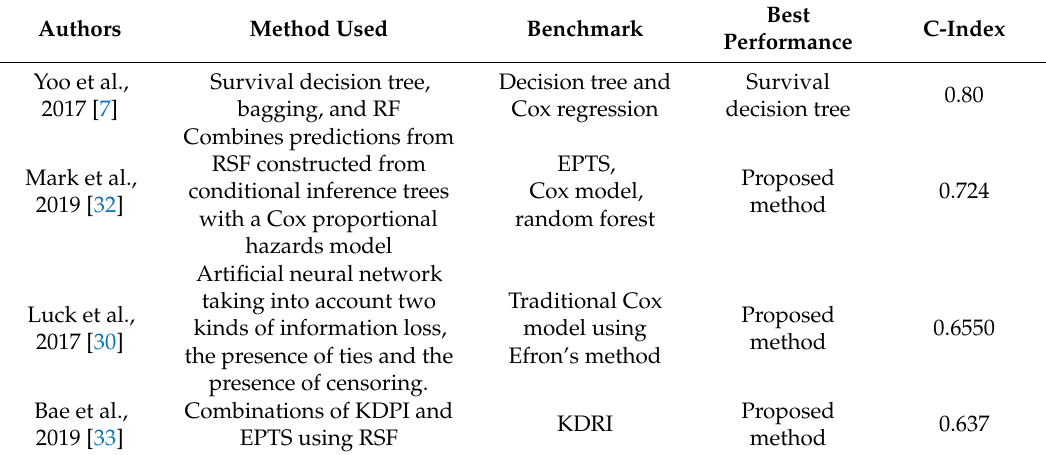
Table 3. Modelling the patient survival